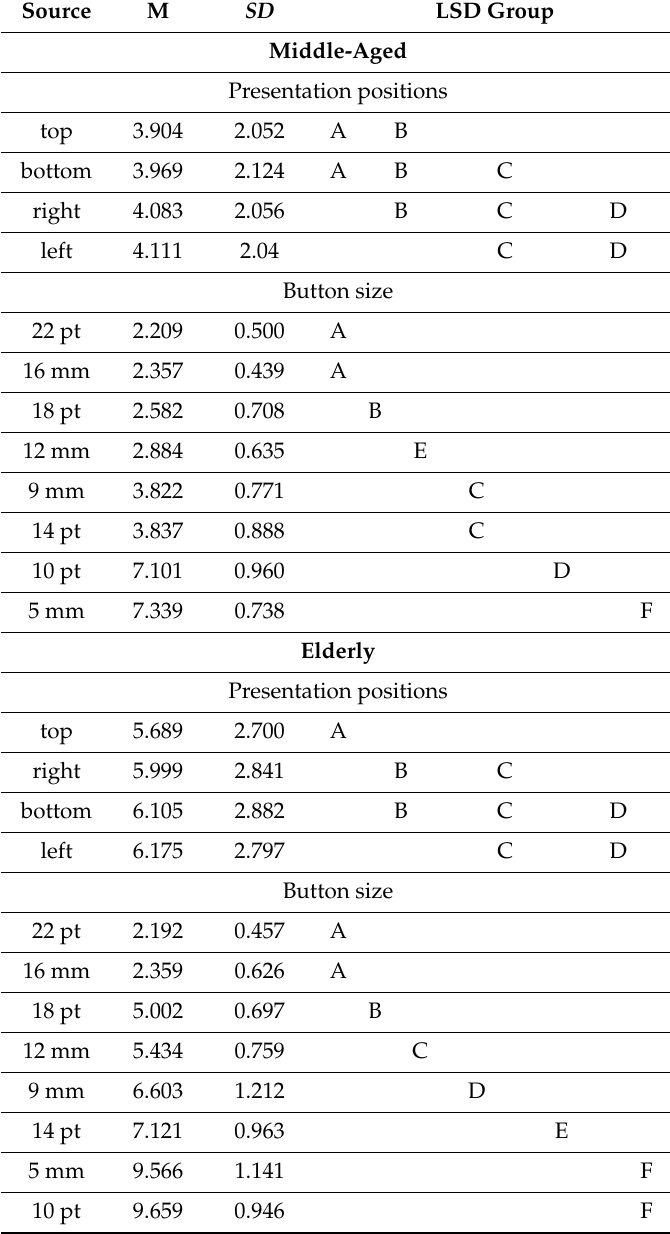
Table 3. Left-stochastic decomposition (LSD) table of presentation positions and button size for the two